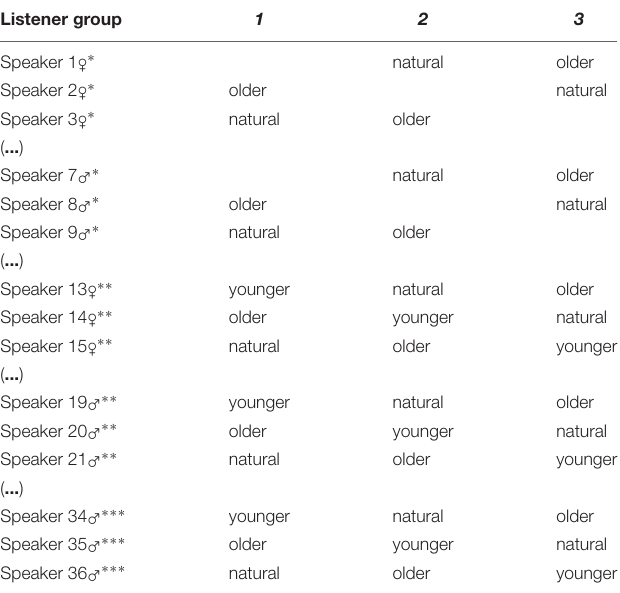
TABLE 2 | Illustration of the composition of speech samples (disguised to sound younger/natural/disguised to sound older) in three different listener